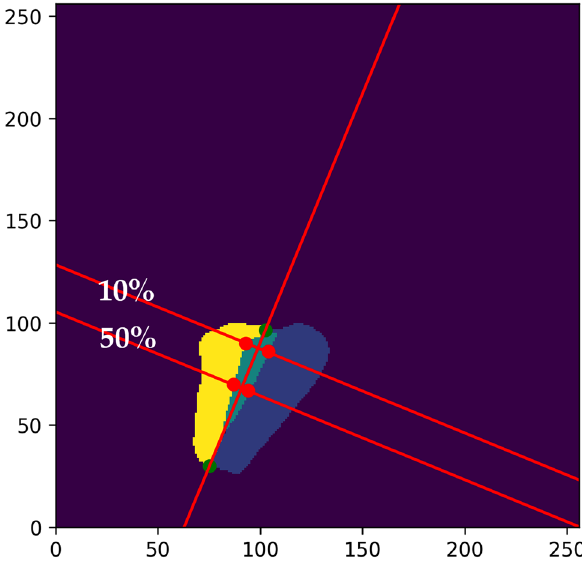
Fig. 4d. The upper collision between the top of the vocal folds, and the collision between the top of the glottis is often the same point, which is the reason for there seemingly only being three points. The distance between the upper and lower collision between the glottis and the line is determined, and points are drawn between these, so that the distance between the new point and the upper collision is 10% of the distance between the upper and lower collision points, and the distance between the new point and the lower collision is 90% of the distance between the upper and lower collision points as seen in Fig. 4e. The distance between the upper and lower collision between the vocal folds and the line is determined, and the distance between the point we drew, and the lower collision point is measured, and the latter is divided with the first and the result is stored as the 10% distance. The algorithm will loop through the data of all the segmented images and complete the process for each to determine the length across the glottis similar to Fig. 4f. A point is drawn between the upper and lower collision of the glottis and the regression line, so the distance between the new point and the lower collision divided by the total distance between the lower and upper colli- sion is the same as the previously stored 10% distance. We draw a line perpendicular to the regression line at the 10% distance from the rear as seen in Fig. 4g. The collision between the perpendicular line and the edges of the glottis is measured to quantify the distance between the vocal folds at a specific point as seen in Fig. 4h. This method for measuring the distance at the upper 10 percent of the glottis allows for keeping a fixed point that can move and rotate with the vocal folds and can handle if the camera zooms in or out. The algorithm was reproduced for a 50% line between the front and the rear glottis. The visualization of both lines in the full coordinate system is seen in Fig. 5. This was used as a proof-of-concept for determining if the algorithm could identify insufficient closure of the vocal folds at specified points. The storing of the glottis area (including the left and right vocal folds) and the calculation of the lines across the glottis at 10% and 50% distances from the rear point were performed. The distance was counted in pixels in a 256 × 256 coordinate system. The 50% lines were made for comparison; no difference in the distance during phonation was expected between the two groups at 50%. Statistical calculations. Data were analyzed in a linear mixed-effect model using REML, including the group (glottal gap/normal) as a fixed effect and the subject as a random effect; N: number of subjects; and n: number of observations. The group differences between the subjects with a rear glottal gap and the normal sub- jects are presented as least-squares means (LS means) with a corresponding 95% confidence interval. The mixed linear model was used because it is an extension of simple linear models to allow for both fixed and random effects, particularly used when there is nonindependence of the data. The SAS statistics show a dif- ference between the 10% lines measured in pixels. Institutional review board statement.